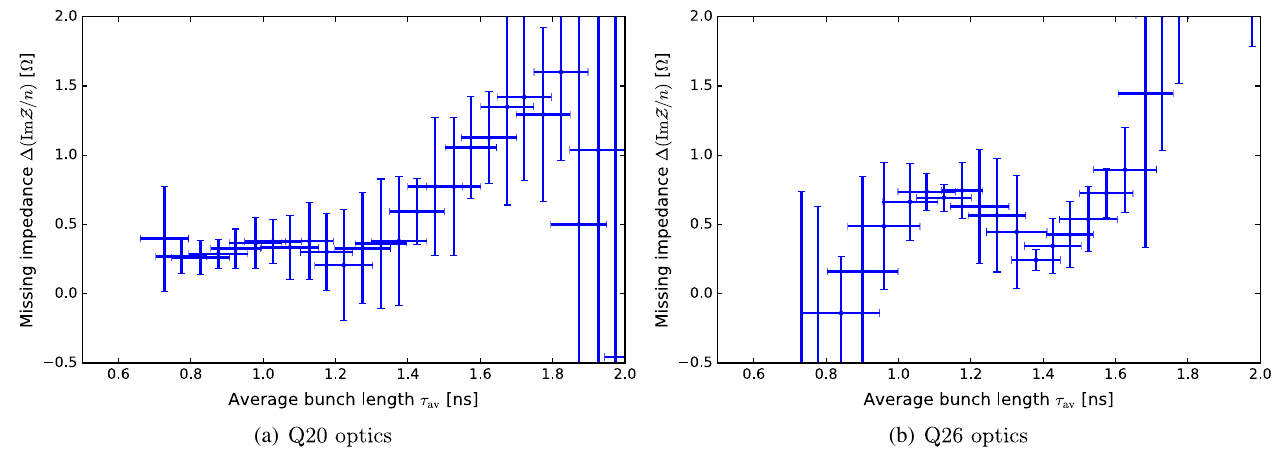
FIG. 17. Missing inductive impedance Im Z =n as a function of bunch length needed to get a perfect agreement between measurements and simulations shown in Fig. 15 for both Q20 (left) and Q26 (right) optics.